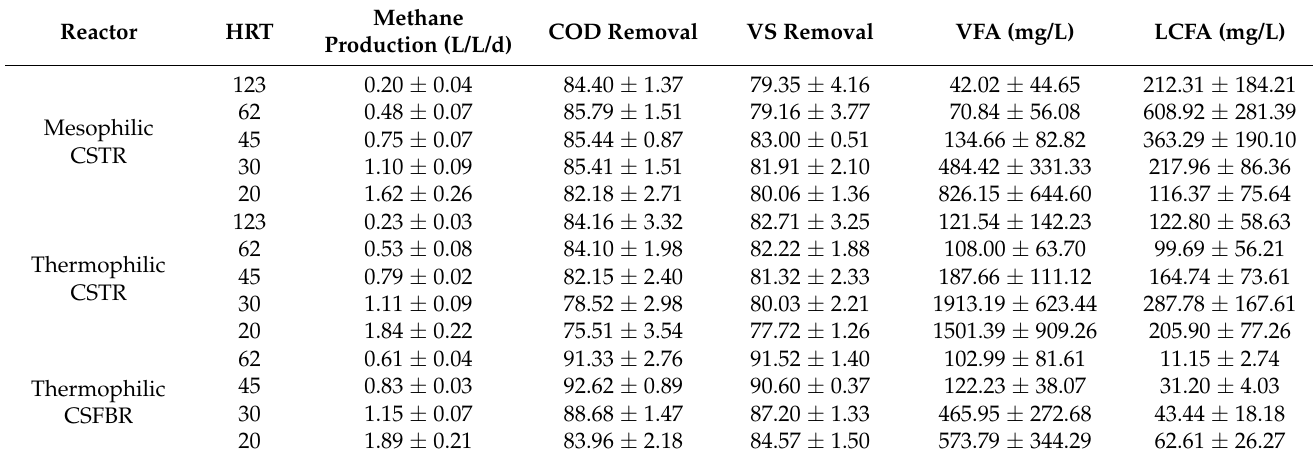
Table 2. Performance and fatty acids in the effluent of three